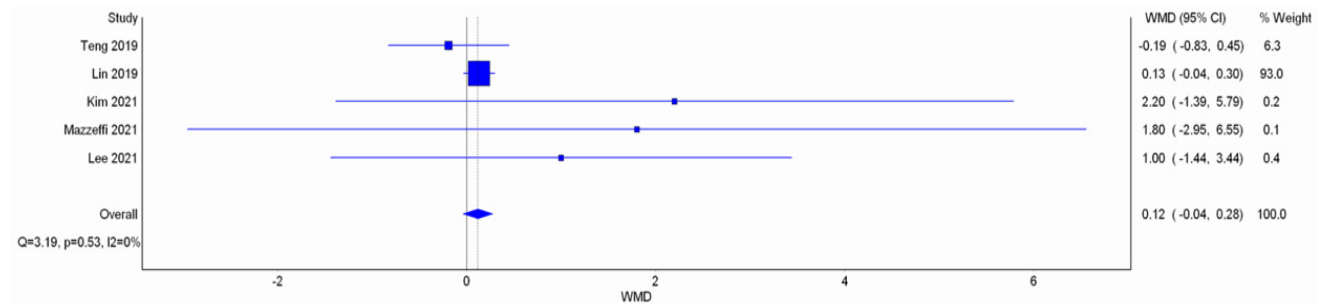
Figure A10. Trial sequential analysis: duration of procedure. All five studies.